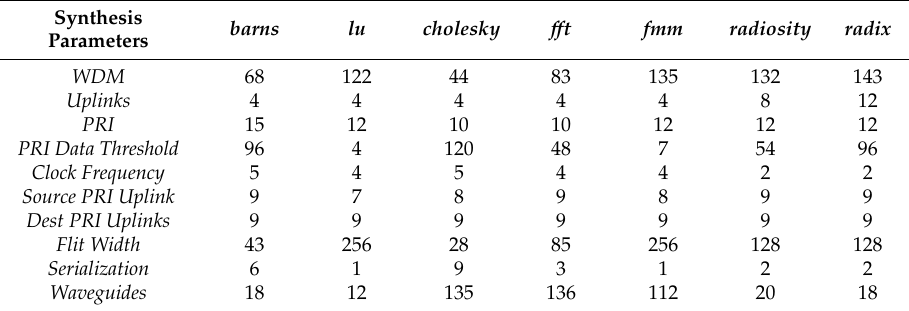
Table 3. PSO Synthesis